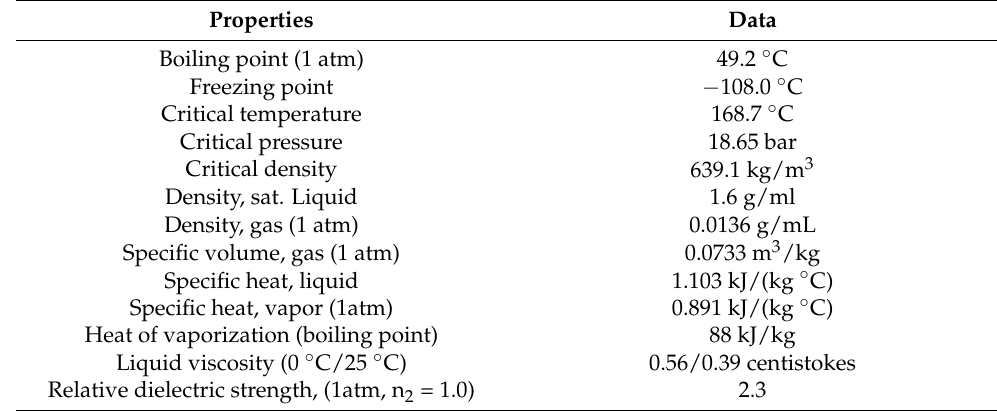
Table 2. Thermophysical parameters of C 6 F 12 O at 25 ◦ C originated from technical data of 3M company